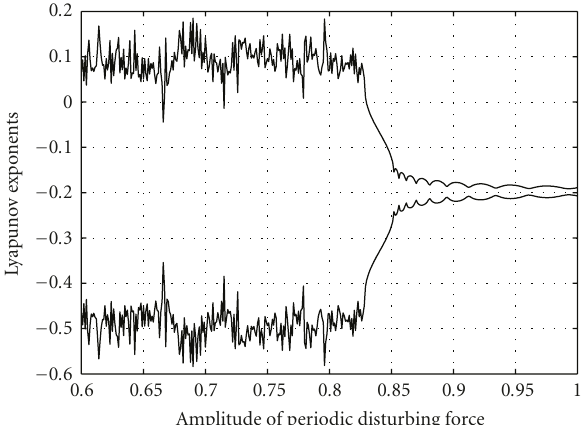
Figure 2: Nonzero Lyapunov exponent curve via the f from 0.600 to